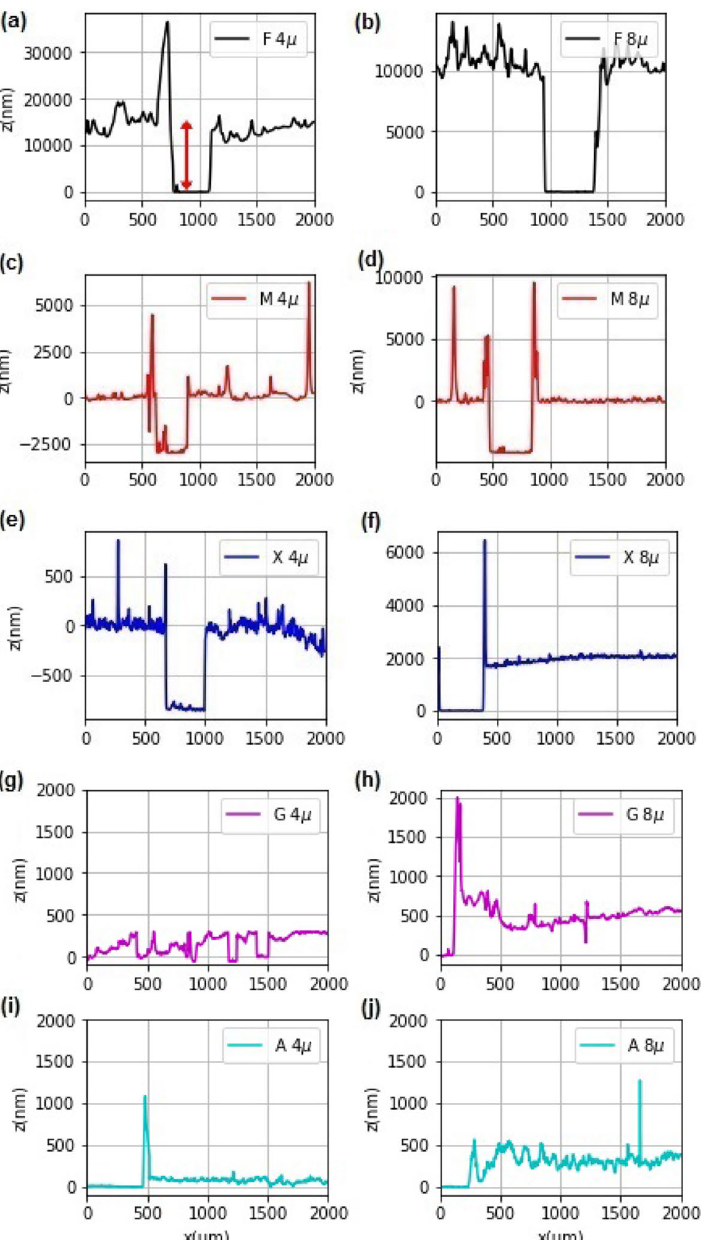
Figure 1. Surface roughness of the dried solution-cast coatings recorded along a 2 mm scan over the surface, involving a step in some